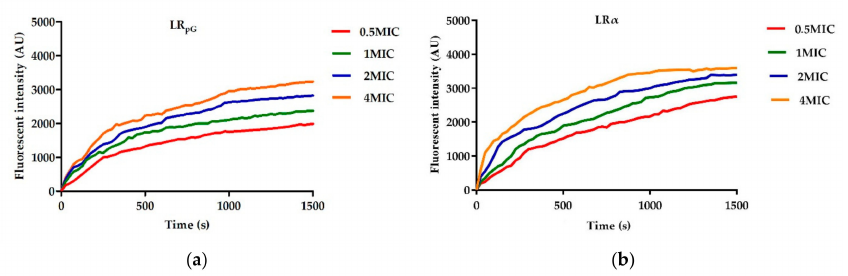
Figure 5. Cytoplasmicmembranepotentialvariationof E.coli ATCC25922treatedwith( a )LR pG and( b )LR α at different levels of concentration. The diagram is based on at least three independent experiments.